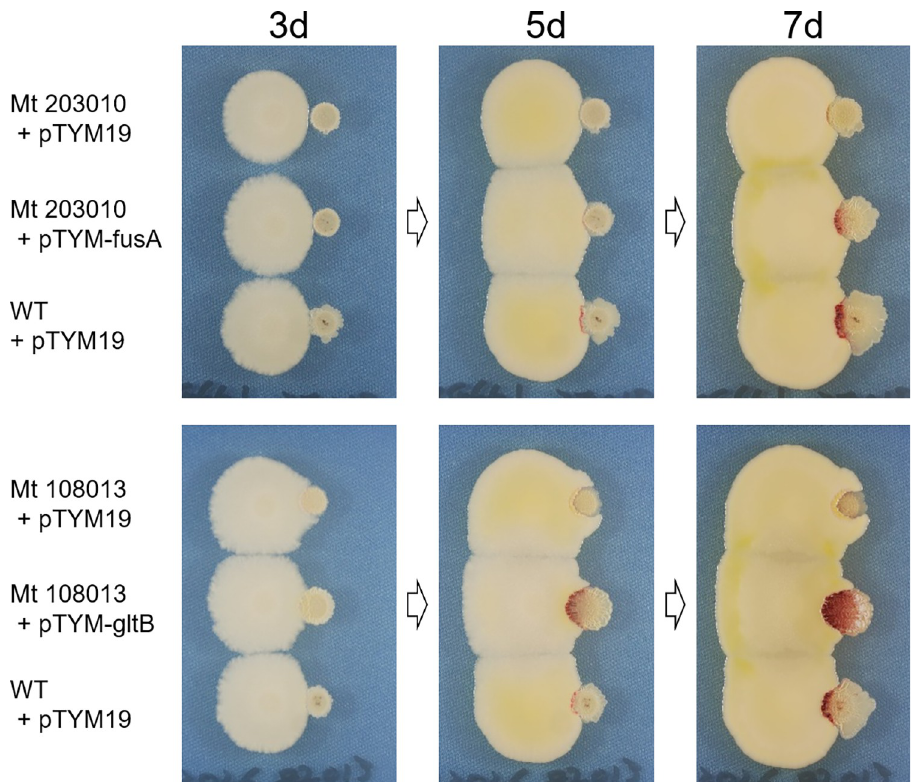
Fig 3. Gene complementation of gltB in Mt 108013 and fusA in Mt 203010 rescued the productivity of RED in condition interacting with T . pulmonis .